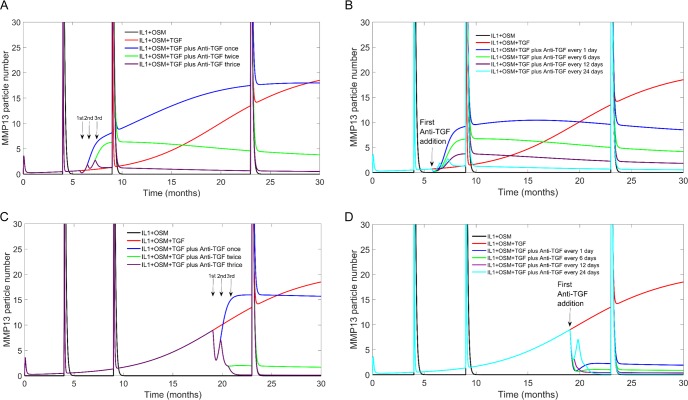
The effects of Anti-TGF treatment, on MMP-13 mRNA expression.Deterministic simulation results for the complete model, with an extra reaction to allow RUNX2 inactivation. The data show the change in MMP-13 mRNA across a 30-month simulation time. IL-1+OSM were triggered using events at 4, 9 and 23 months. The model also contained the species “Anti-TGF” which targeted and degraded both active and inactive TGFβ. Anti-TGF concentration was at zero when the simulation started. A) At 6 months Anti-TGF was added to the system, using an event. Anti-TGF was added either once, twice or thrice with a 24 days interval between each addition. B) At 6 months Anti-TGF was added to the system, using an event. Anti-TGF was added three times to the model with either a 1-day, 6-day, 12-day or 24-day interval between each addition. C) At 15 months Anti-TGF was added to the system, using an event. Anti-TGF was added either once, twice or thrice with a 24 day interval between each addition. D) At 19 months Anti-TGF was added to the system, using an event. Anti-TGF was added three times to the model with either a 1-day, 6-day, 12-day or 24-day interval between each addition.